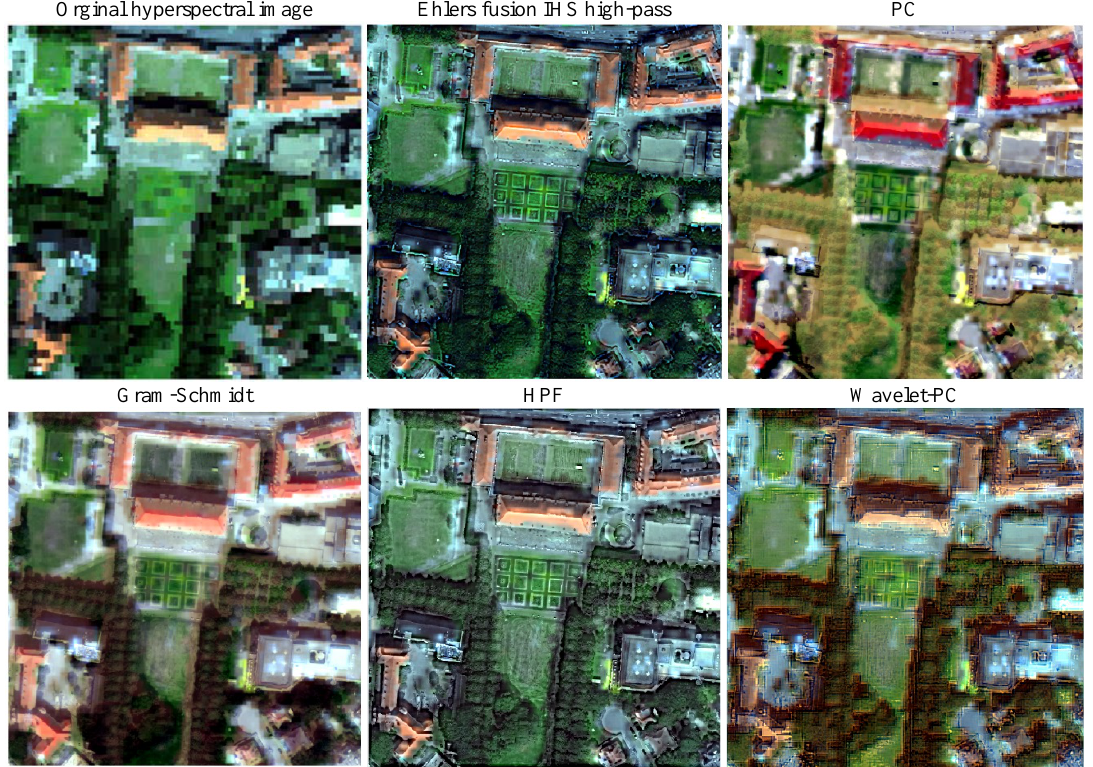
Figure 9. From top left to bottom right: original hyperspectral image, image sharpening results from Ehlers fusion, PC, Gram- Schmidt, Spatial domain High pass filter, Wavelet